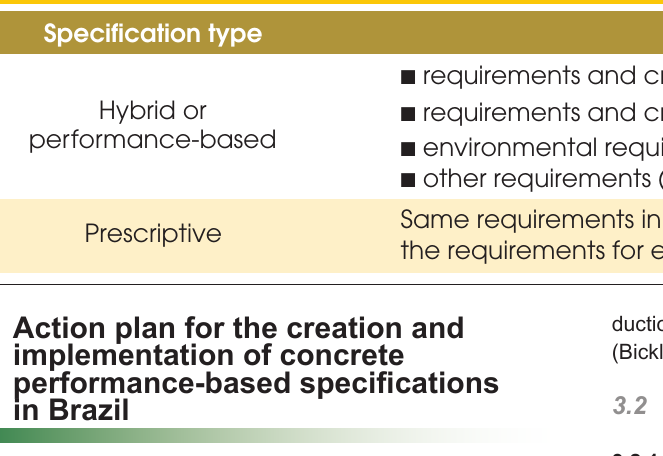
Table 1 – Suggested alternative method for specifying concrete based on CSA A23.1-04 (CSA